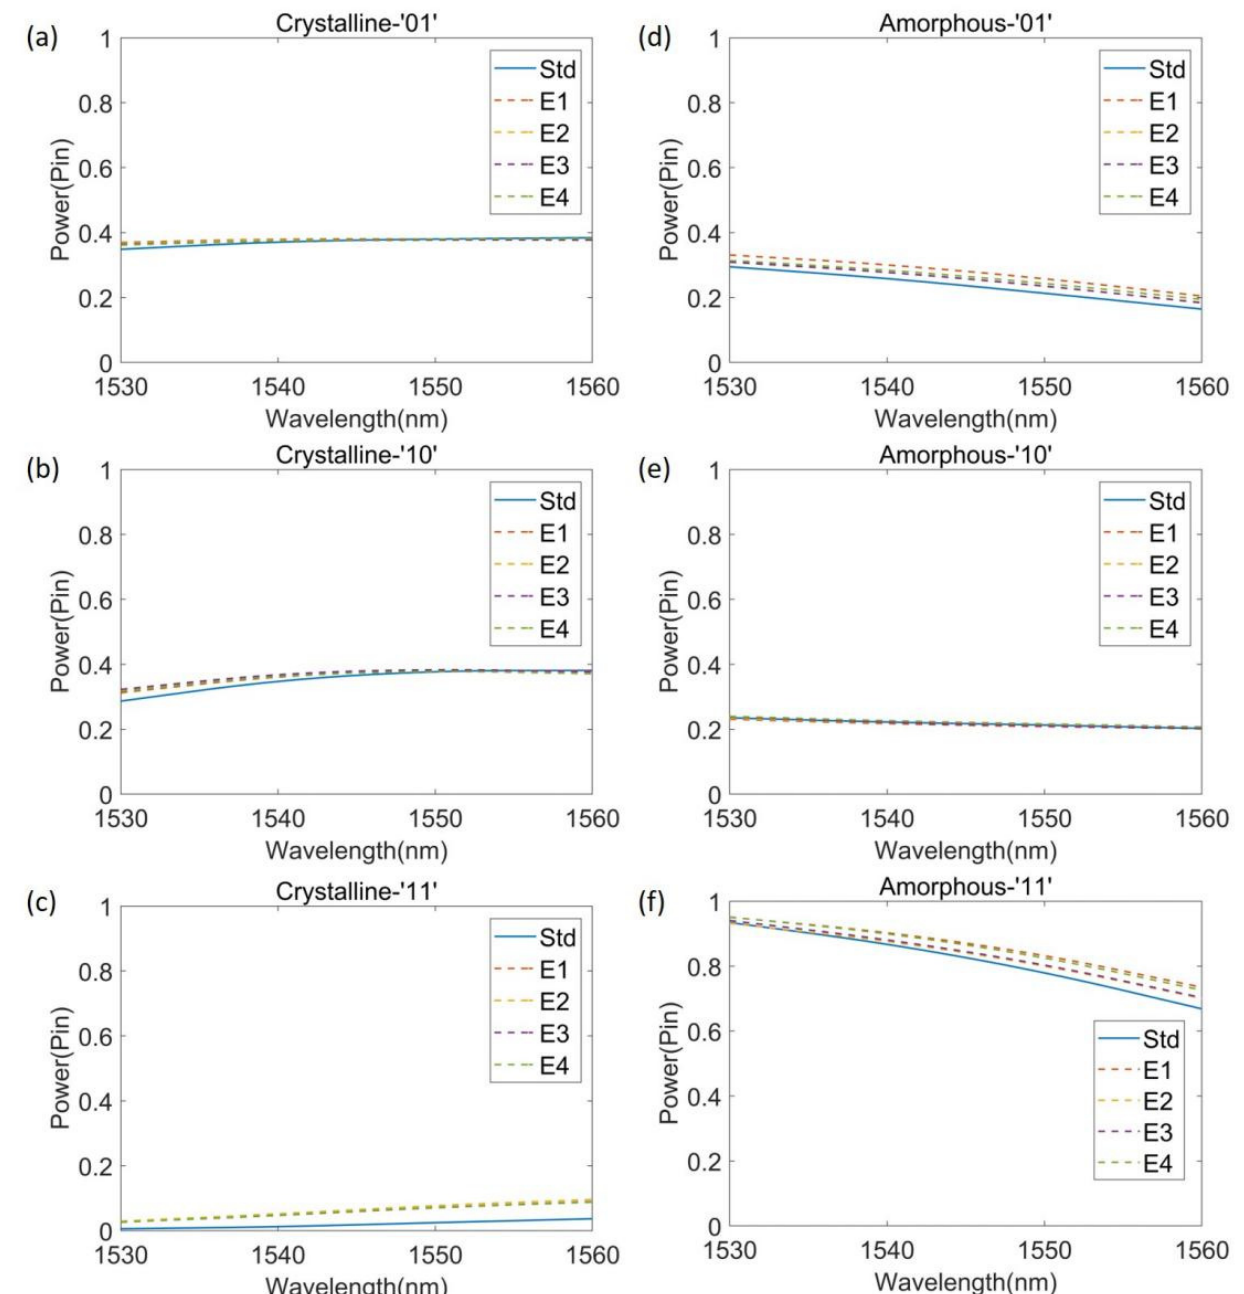
Figure 7. Analysis of fabrication tolerances. Comparison of the intensity between the standard device and devices with an etching error. ( a ) XOR gate with the input state of ‘01’; ( b ) XOR gate with the input state of ‘10’; ( c ) XOR gate with the input state of ‘11’; ( d ) AND gate with the input state of ‘01’; ( e ) AND gate with the input state of ‘10’; ( f ) AND gate with the input state of ‘11’.